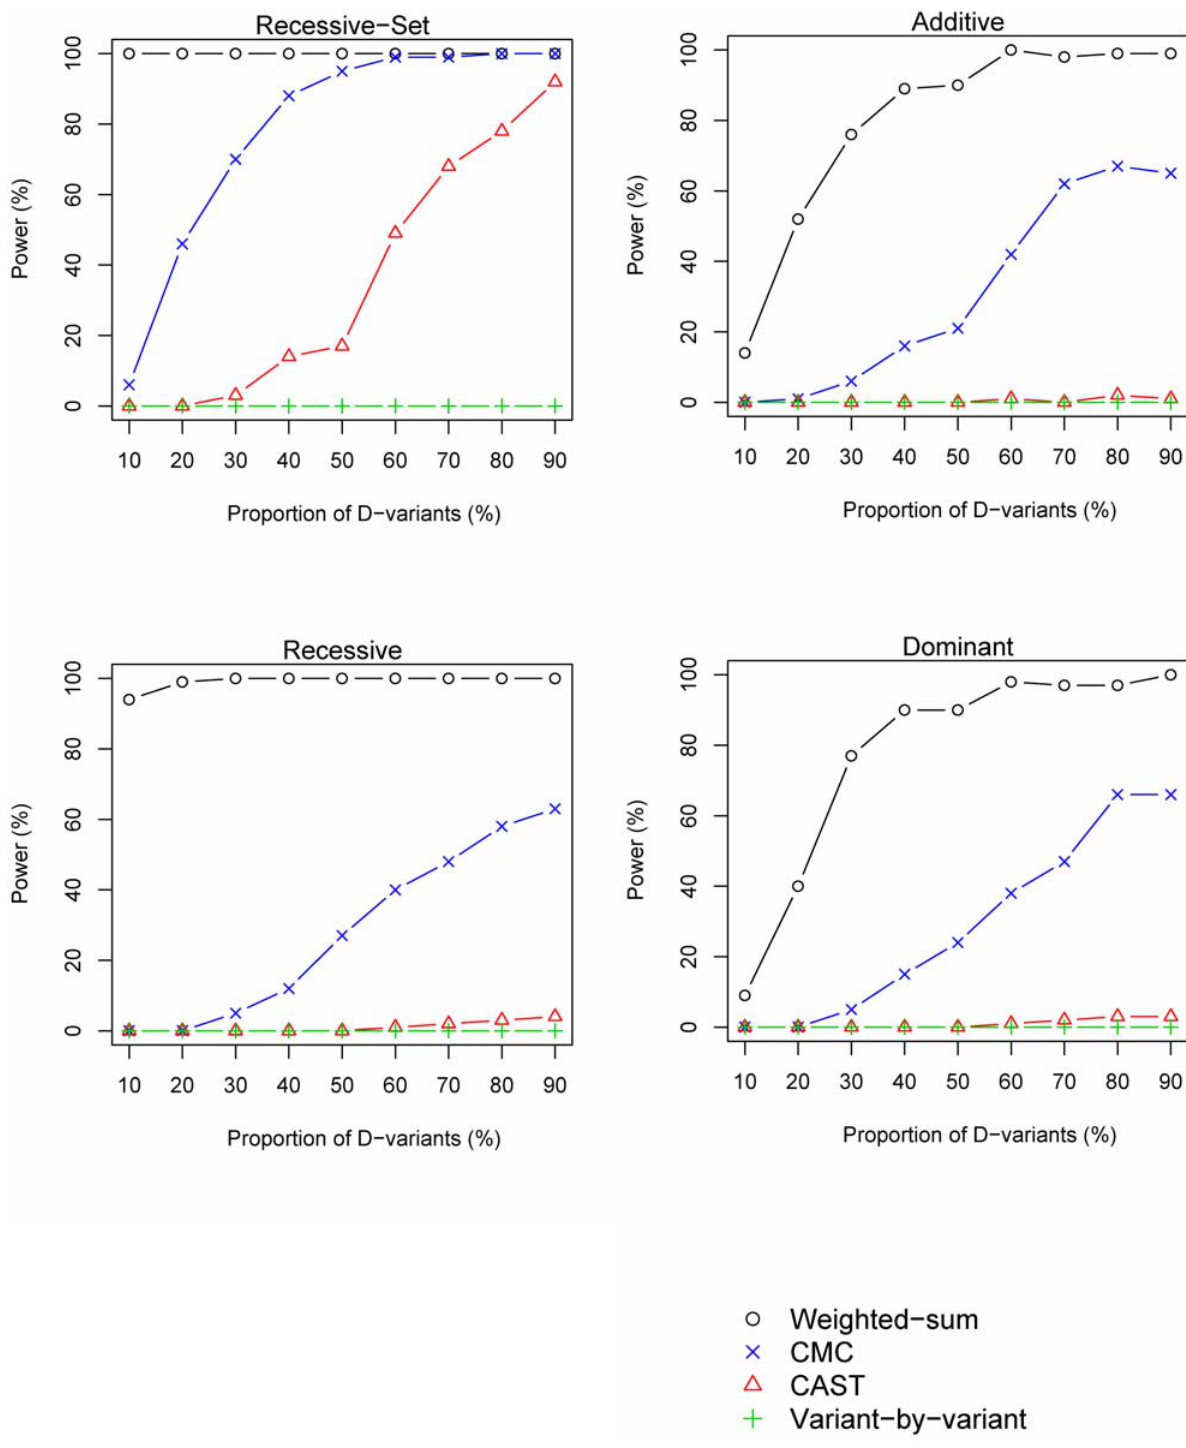
Figure 4. Power versus proportion of D-variants. The power of the investigated methods is shown for different proportions of D-variants (disease-risk contributing variants). The power simulations were performed using n A = n U =1000 individuals, 50 D-variants, group PAR of 10% and p M =10%.